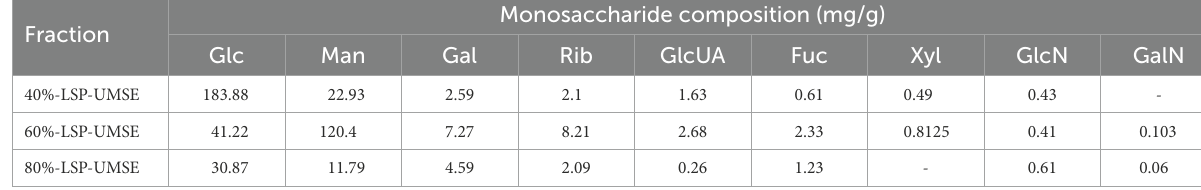
TABLE 2 Monosaccharide compositions of the LSP.